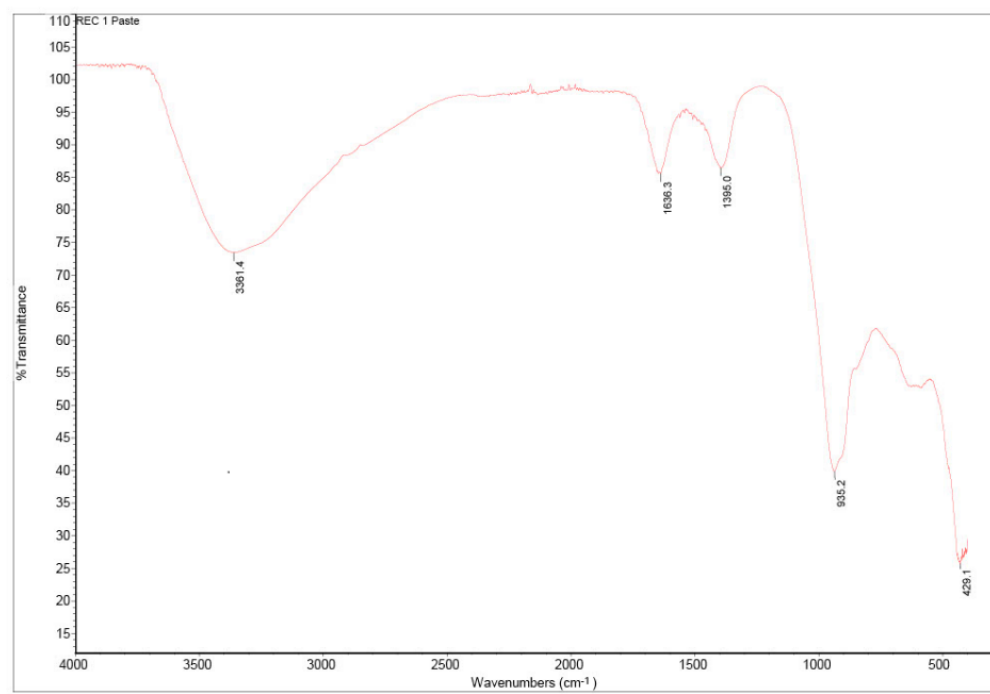
Figure 11. FTIR analysis for REC 1.